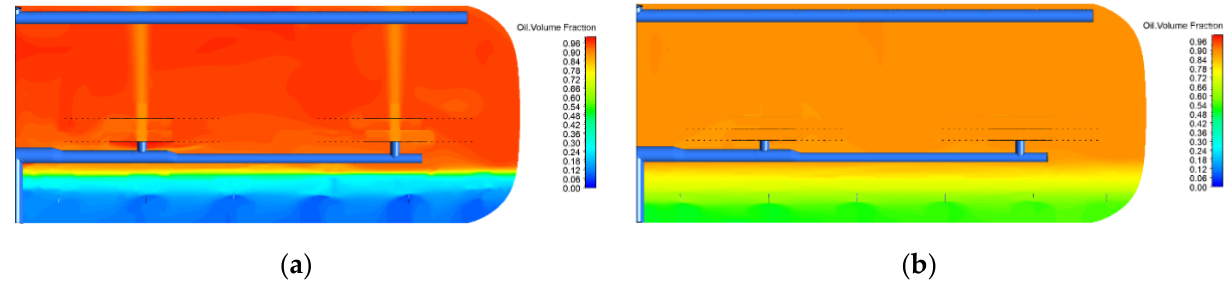
Figure 3. Effect of the electric field on the oil volume fraction in a longitudinal plane for ( a ) high electric field, experiment 11 (D = 1 µm, µ = 0.071 kg/ms, x = 0.12, and E = 3 kV/cm); ( b ) low electric field, experiment 15 (D = 1 µm, µ = 0.071 kg/ms, x = 0.12, and E = 0.1 kV/cm).